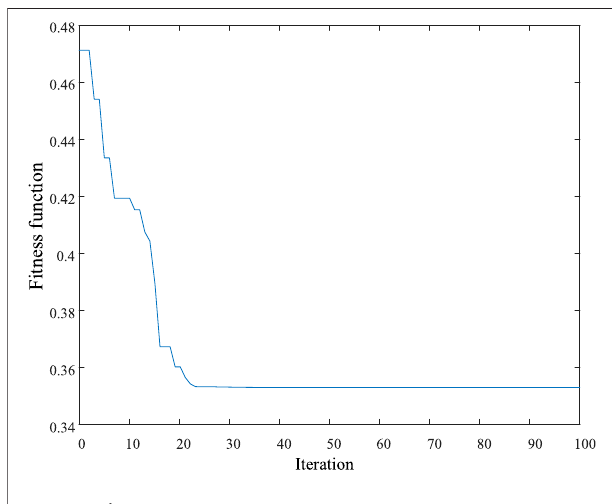
FIGURE 9 | Convergence